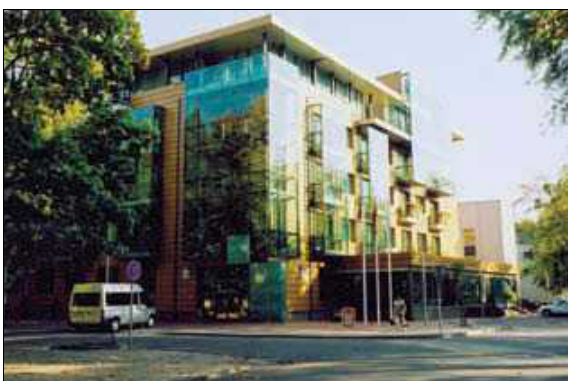
Fig. 3. hotel “Druskininkai“ in V. kudirka st (former hotel “tourist”, author: a. Sprindys, 1960; after renovation in 2004, authors: a. taujanskas, L. Meškys, D. budvytytė)